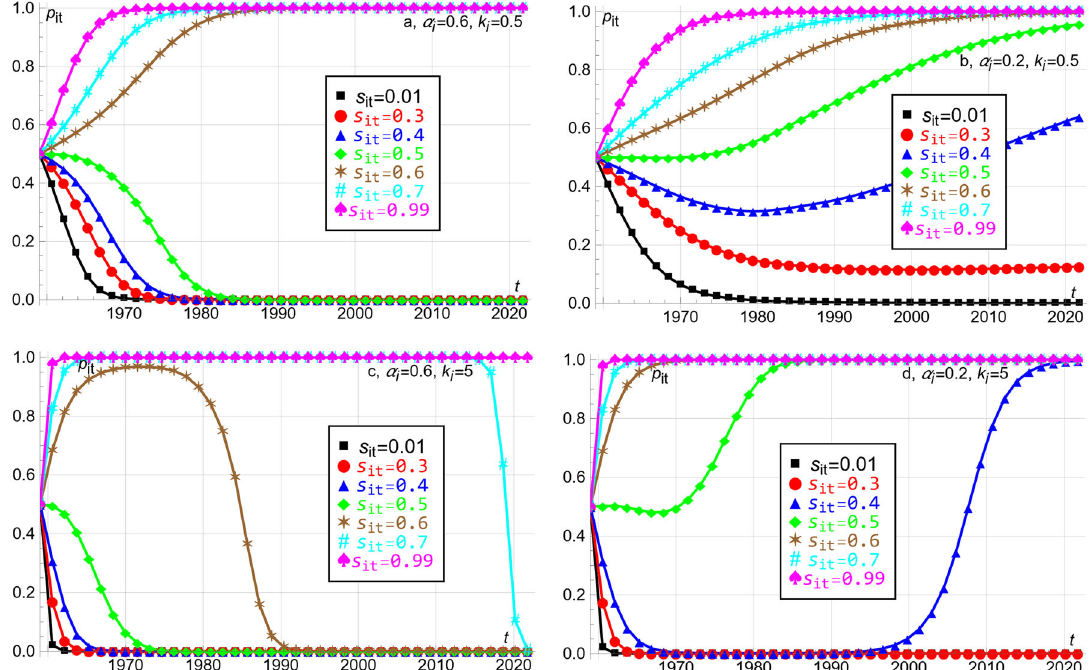
Fig. 3 The volume fraction p it of player i ’ s transactions in currency g at time t 1959 – 2021 with simpli fi ed utilities u igst and u inst in Eqs. (1) and (2) when ¼ 0 : 5, μ = 0, and 0 : 01 (cid:4) s p it i 0